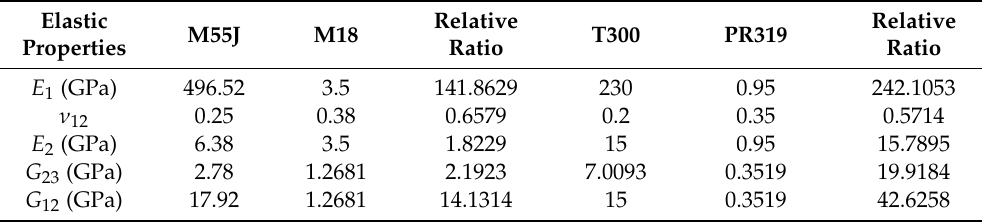
Table 3. Elastic properties of fibers and matrices and the relative